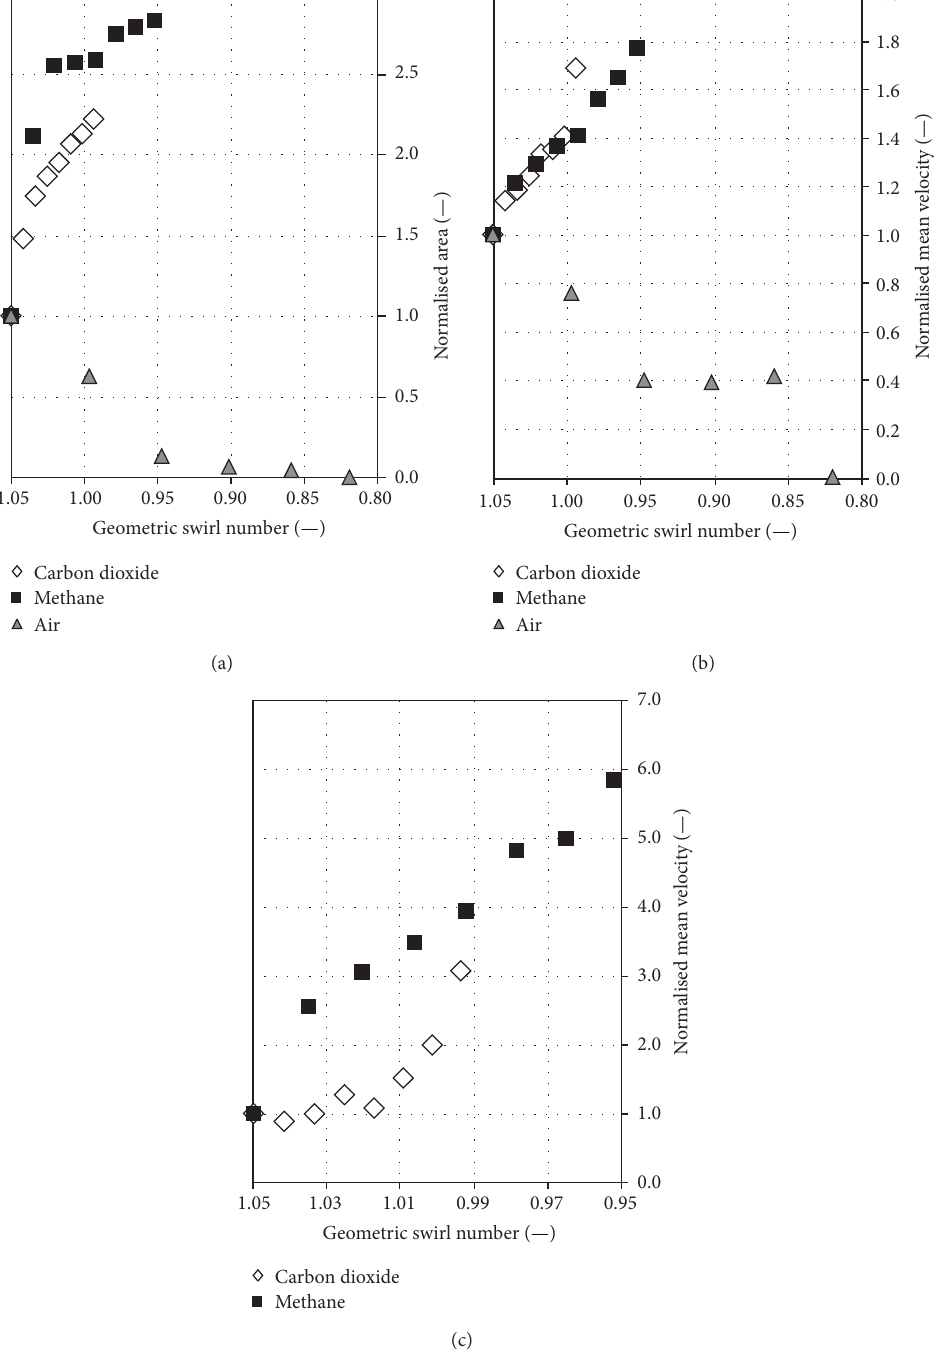
Figure 11: The normalised effect of the injection of carbon dioxide, methane, and air on (a) cross sectional area and (b) mean velocity of the entire CRZ and (c) mean velocity of the CRZ